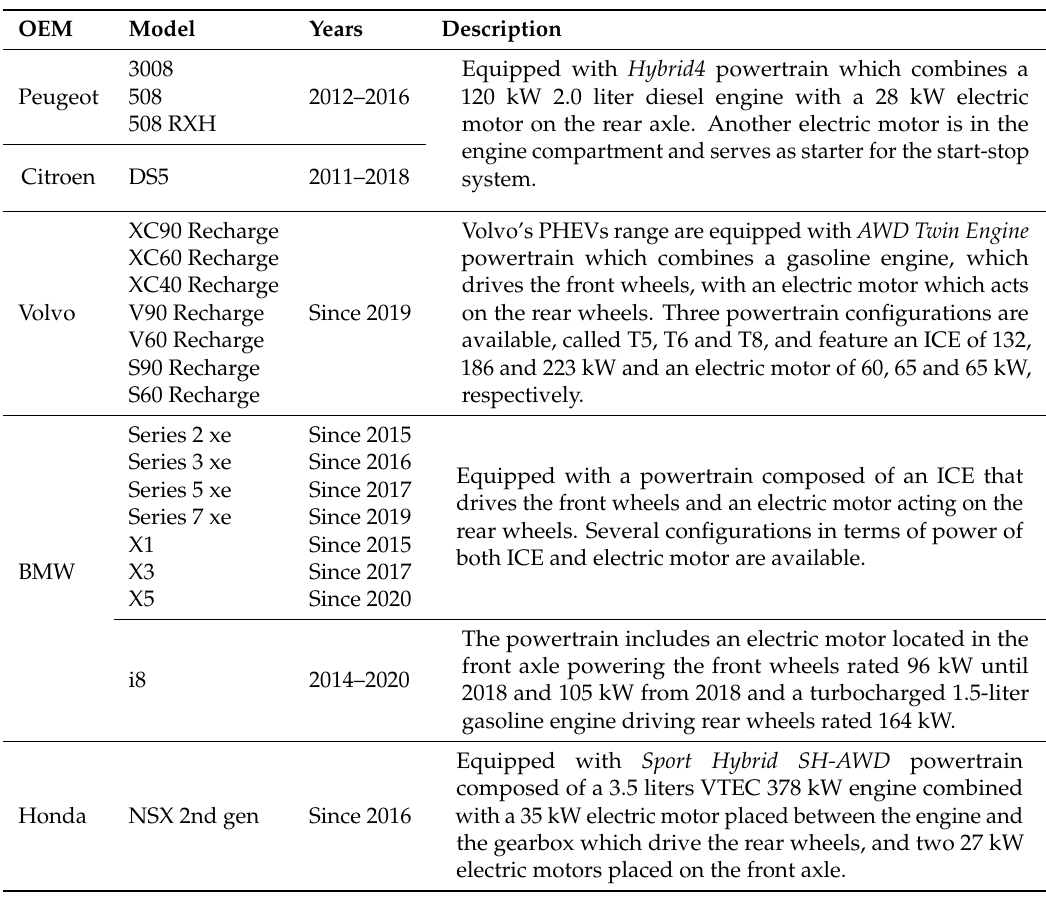
Table 1. Commercial hybrid vehicles using a TTR